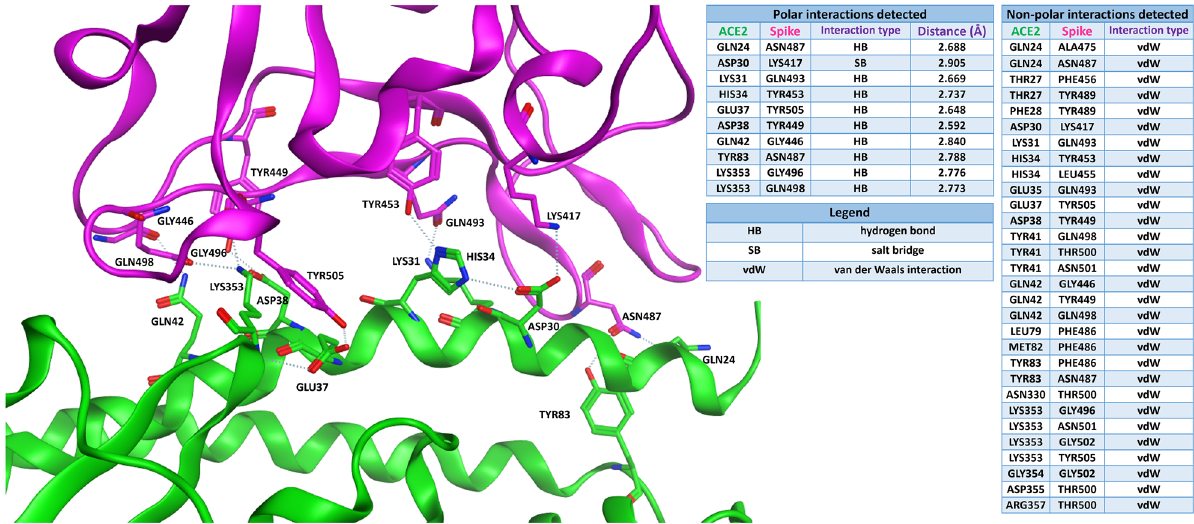
Figure 2. The typical situation of viral Spike protein RBD (PDB: 6M0J, violet-colored) binding to ACE2 receptor (green). The tables on the right report the polar and the non-polar interactions in which the residues on the interface are involved. For the polar interactions, also the distance between the interacting atoms (measured in angstroms) is reported in the table. To get a better visual representation of the contacts, just the residues engaged in the polar interactions are labelled in the 3D image on the left, while all the non-polar interactions are omitted.